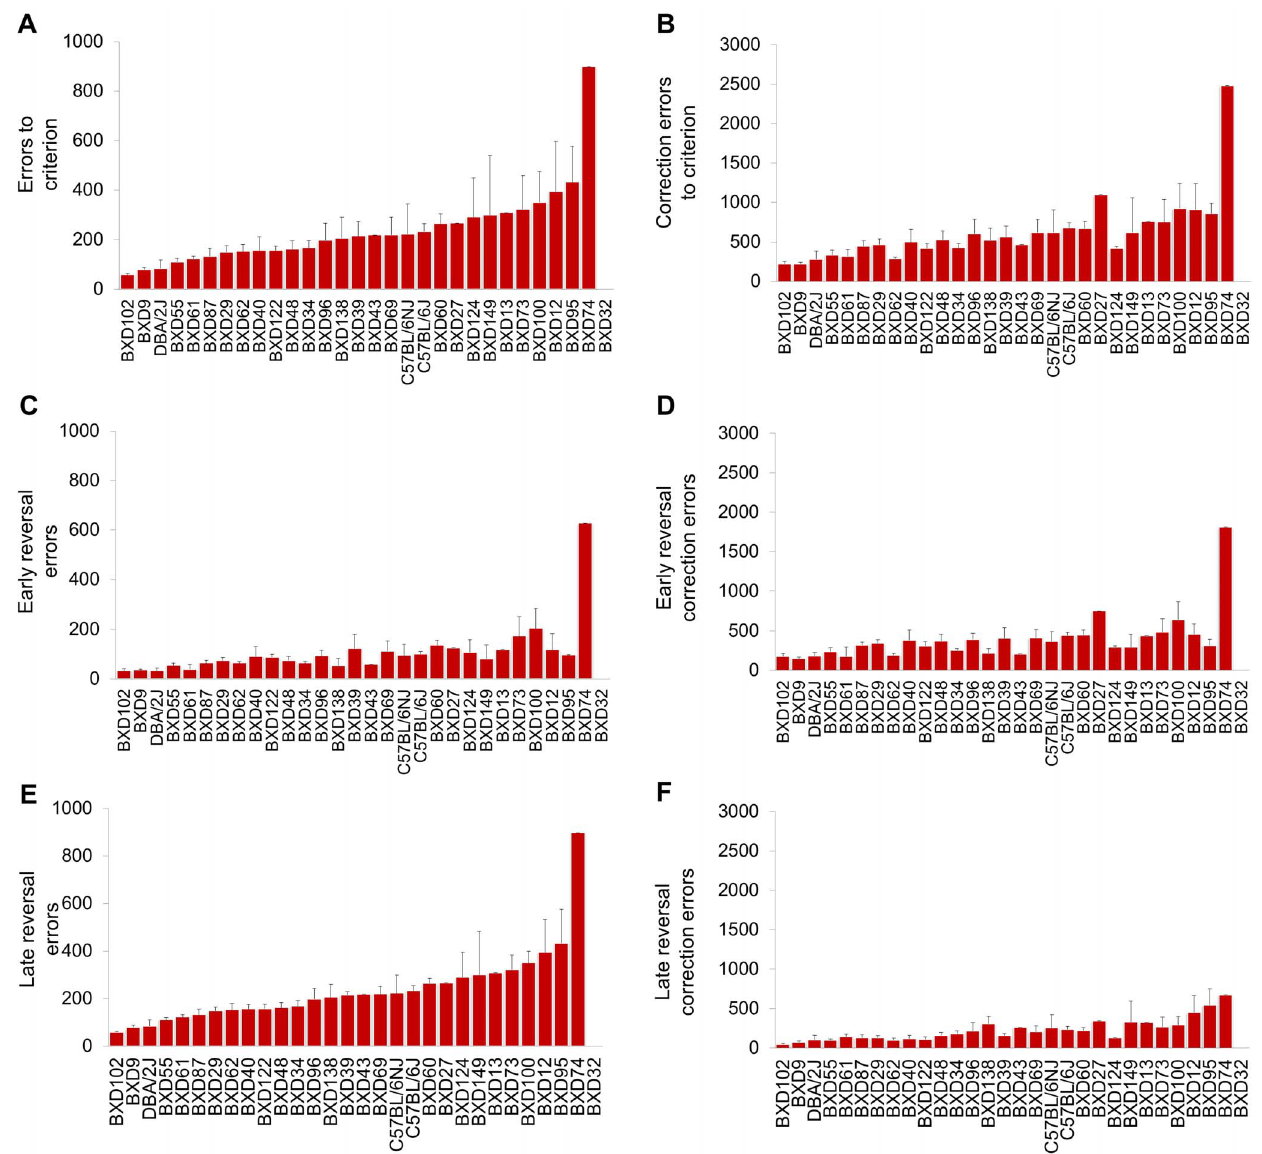
Figure 5. BXD-RI strain differences in reversal learning. Errors ( A ) and correction errors ( B ) to reversal criterion. Errors ( C ) and correction errors ( D ) made during early reversal. Errors ( E ) and correction errors ( F ) made during late reversal. n=1–14 per strain. Data are Means 6